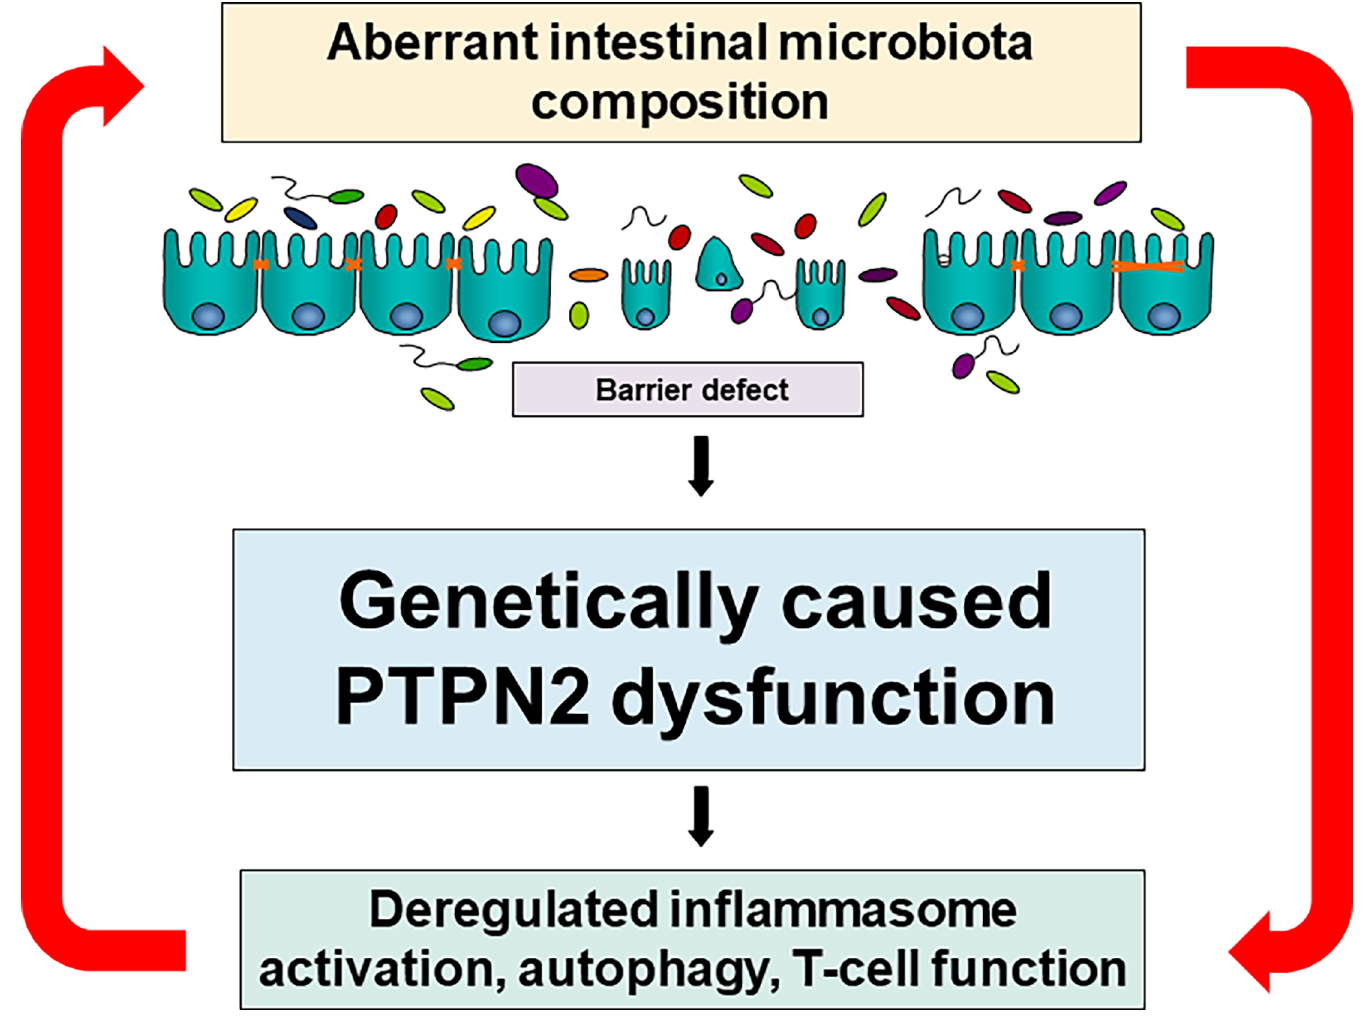
Fig 4. Effects of PTPN2 dysfunction on intestinal microbiota composition. PTPN2-mediated dysfunction of several immune mechanisms that are important for the body’s immune response to luminal bacteria and for maintaining intestinal homeostasis. In particular, dysfunction of autophagy, aberrant inflammasome activation and altered T-cell activation and differentiation seems to play a crucial role for the observed correlation between PTPN2 dysfunction and alterations in intestinal microbiota composition.